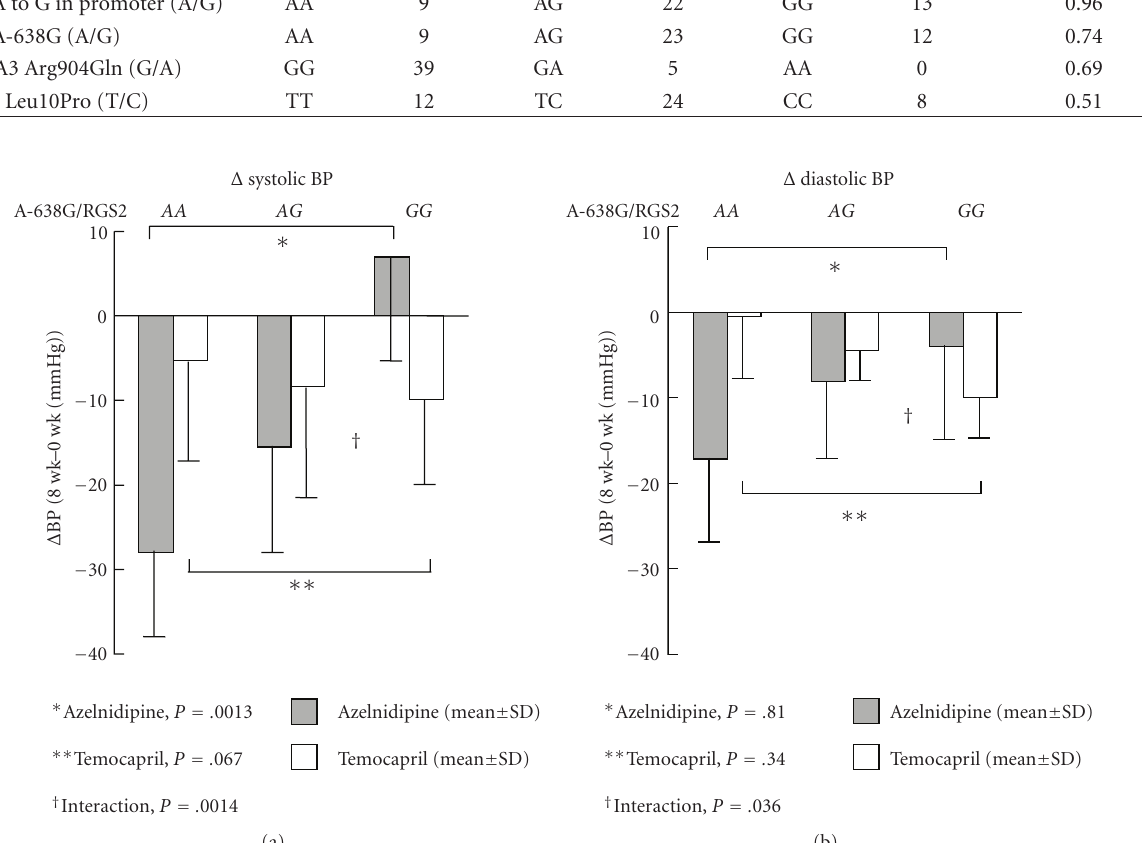
Figure 3: Relationship between A-638G polymorphism of RGS2 gene and BP